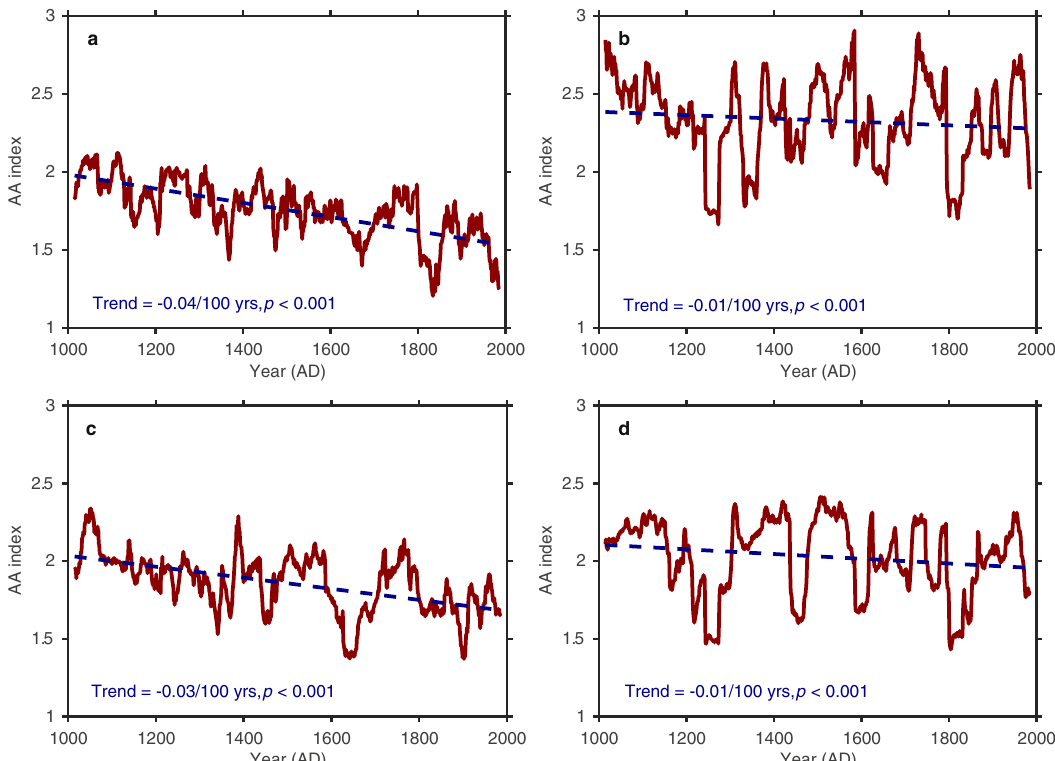
Fig. 3 The reconstructed AA indices and estimated AA trends during the past millennia derived from three PDA-based reconstructions and the mean of CMIP5 multi-model simulations. a PDA-based reconstruction of this study. b Goosse2012. c Steiger2018. d Multi-model mean. The dark red solid line represents the AA index derived from PDA-based reconstructions or the mean of CMIP5 multi-model simulations, and the dark blue dotted line is the long- term trend. The AA index values were computed based on annual temperature anomalies without smoothing with respect to the mean for 1961 – 1990. The long-term trends were computed via Mann-Kendall trend detection (see Methods) for each AA index time